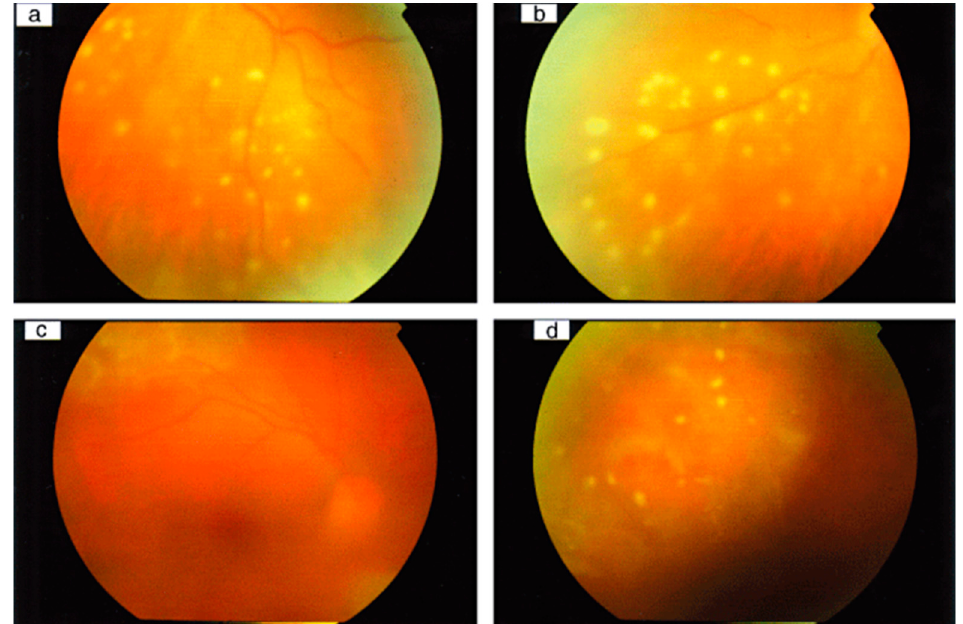
Figure 1. Syphilitic panuveitis patients with punctuate inner retinitis. Color fundus photographs of the left eye of a patient with syphilis, showing ( a ) punctuate inner retinitis overlying deeper retinal inflammation inferotemporally and ( b ) inferonasally without deeper involvement. Color fundus photographs of the right eye of another patient with syphilis, showing ( c ) posterior pole and ( d ) superior views with inner punctuate retinitis and deep diffuse retinitis superior to the superotemporal arcade, with ARTerial sheathing. (Adapted with permission from Ref. [27] . 2010, Edward H Hughes et al.).